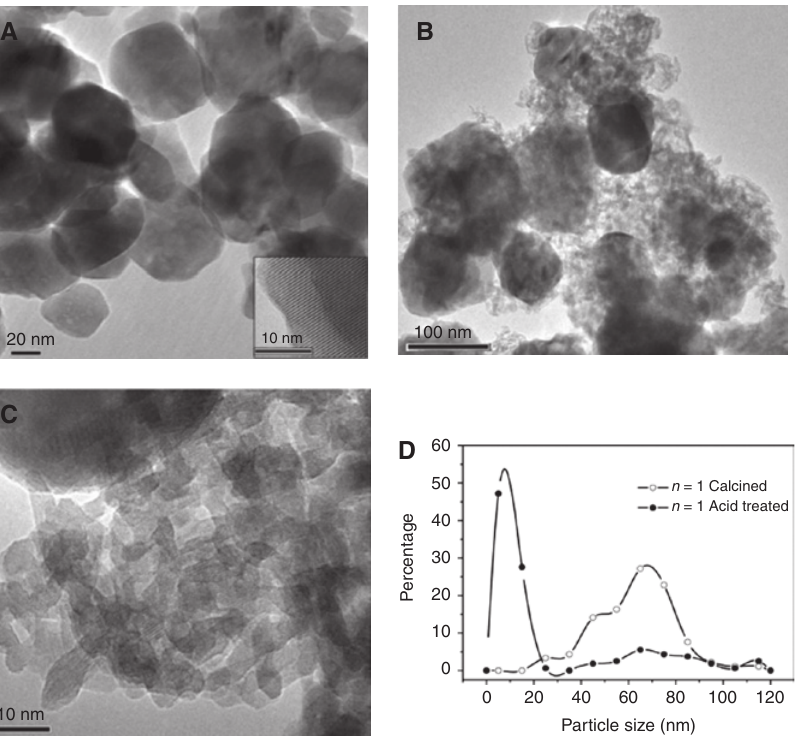
Figure 26: (A) TEM images of calcined n = 1 sample, (B) TEM images of acid-treated n = 1 sample, (C) HRTEM of the acid-treated sample and (D) particle size distribution of the calcined and acid-treated n = 1 sample from TEM images. Reproduced from [138] with permission from the American Chemical